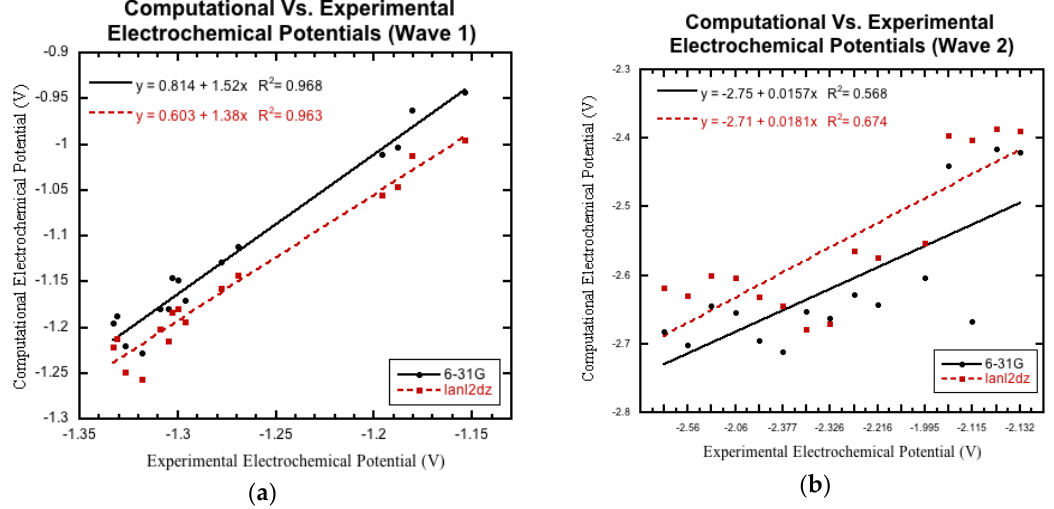
Figure 7. The computationally derived reduction potentials for ( a ) Wave 1 (1st N-oxide reduction) and ( b ) Wave 2 (2nd N-oxide reduction) compared to the previously reported experimentally measured data [27]. The basis set for lanl2dz is shown in red and 6-31g basis set is shown in black. Derivatives C3 and E1–E4 are excluded.